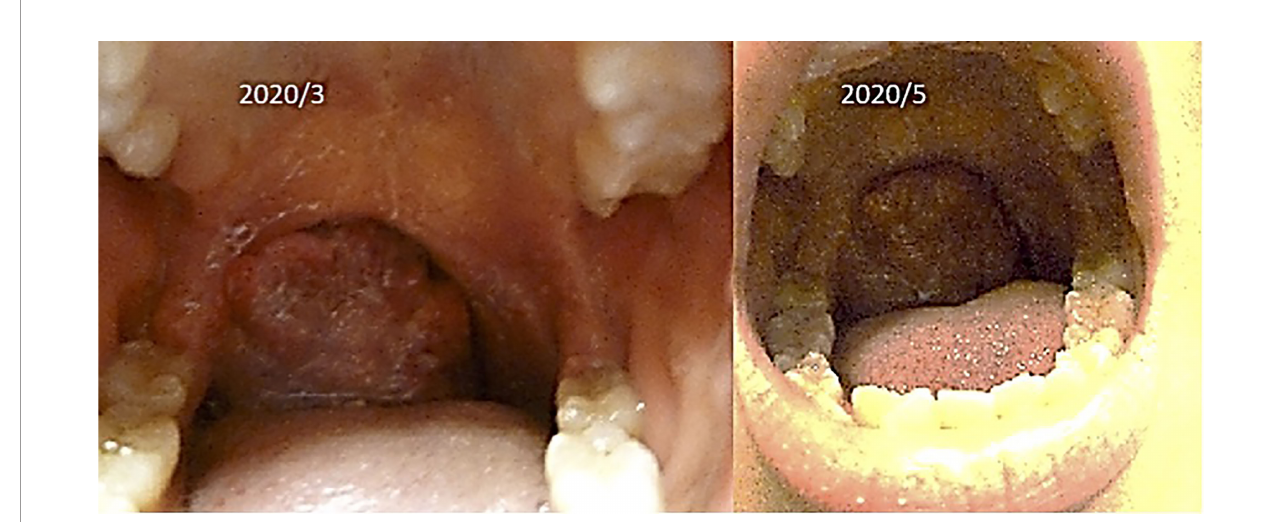
FIGURE 6 | Her tumor of tonsil is